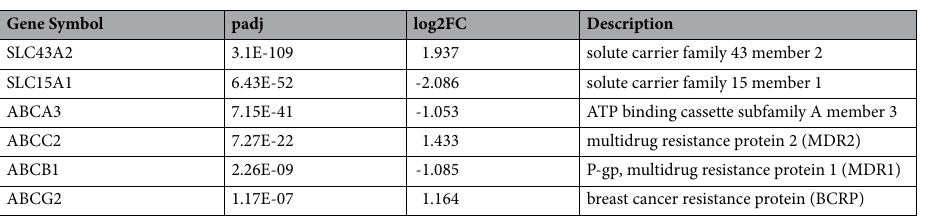
Table 4. Significant expression of genes with importance transportation in proximal tubules. Tables of differential expressed genes corresponding to morphological terms that were highly significant (padj < 0.05).